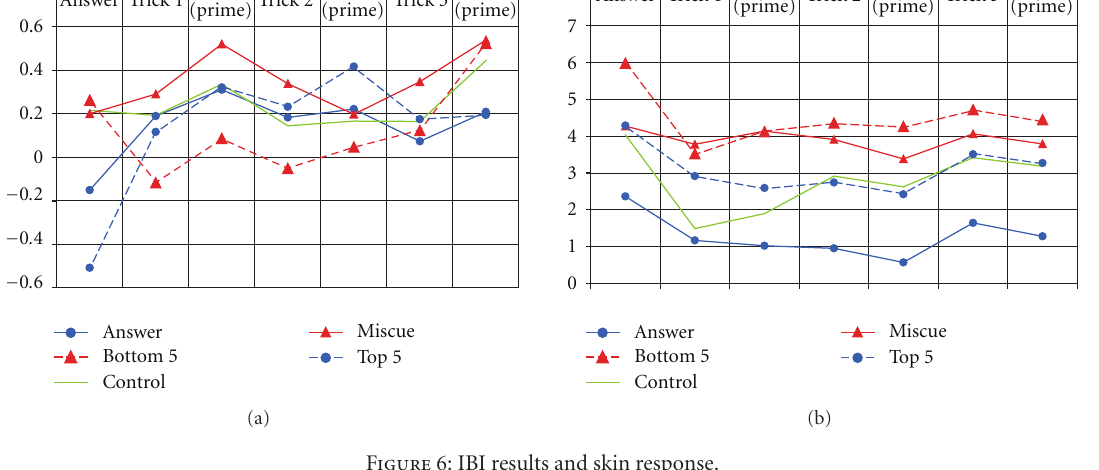
Figure 6: IBI results and skin response.